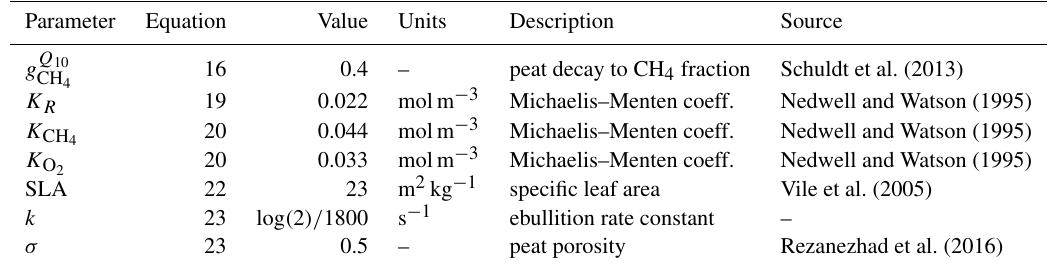
Table 2. Parameters that were not calibrated. Based on an initial sensitivity analysis, the Michaelis–Menten parameters K were not con- strained by the data enough strongly and consistently to include them in the optimization. The same applies for the ebullition half-life, which is understandable given the temporal resolution of the observed data. The peat porosity was dropped from optimization in favor of the diffu- sivity parameters f D, w and f D, a , and the specific leaf area (SLA) was not chosen for optimization since the optimized parameters τ (mm − 1 ) and ρ (m 2 kg − 1 ) are already part of Eq. (22) where SLA appears. The parameter g Q 10 was left out in favor of parameter τ cato , despite their CH 4 functions regarding CO 2 being different but trusting the prior